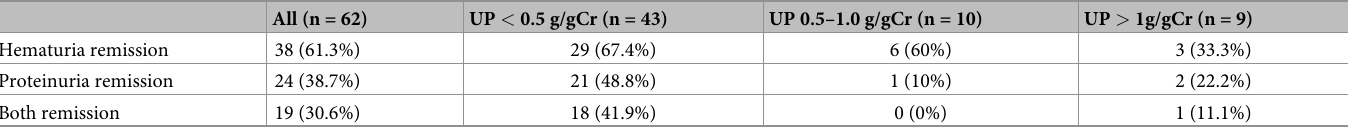
Table 2. Clinical remission by amount of proteinuria.